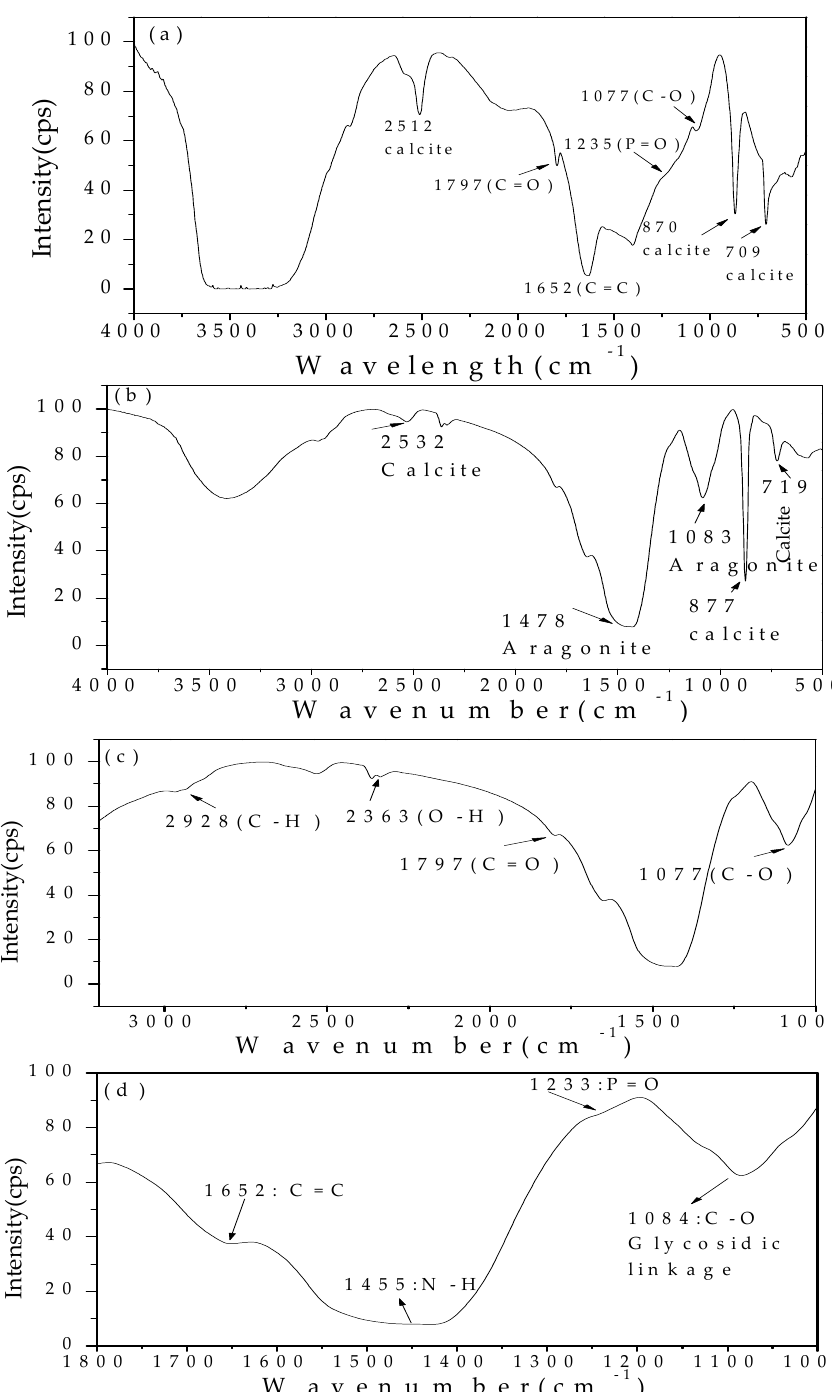
Figure 7. The minerals analyzed by FTIR. ( a ) Calcite at Mg/Ca molar ratio of 0; ( b ) calcite and aragonite at Mg/Ca molar ratio of 3; ( c ) the minerals at Mg/Ca molar ratio of 3 from 1000 to 3200 cm − 1 ; ( d ) the minerals at Mg/Ca molar ratio of 3 from 1000 to 1800 cm − 1